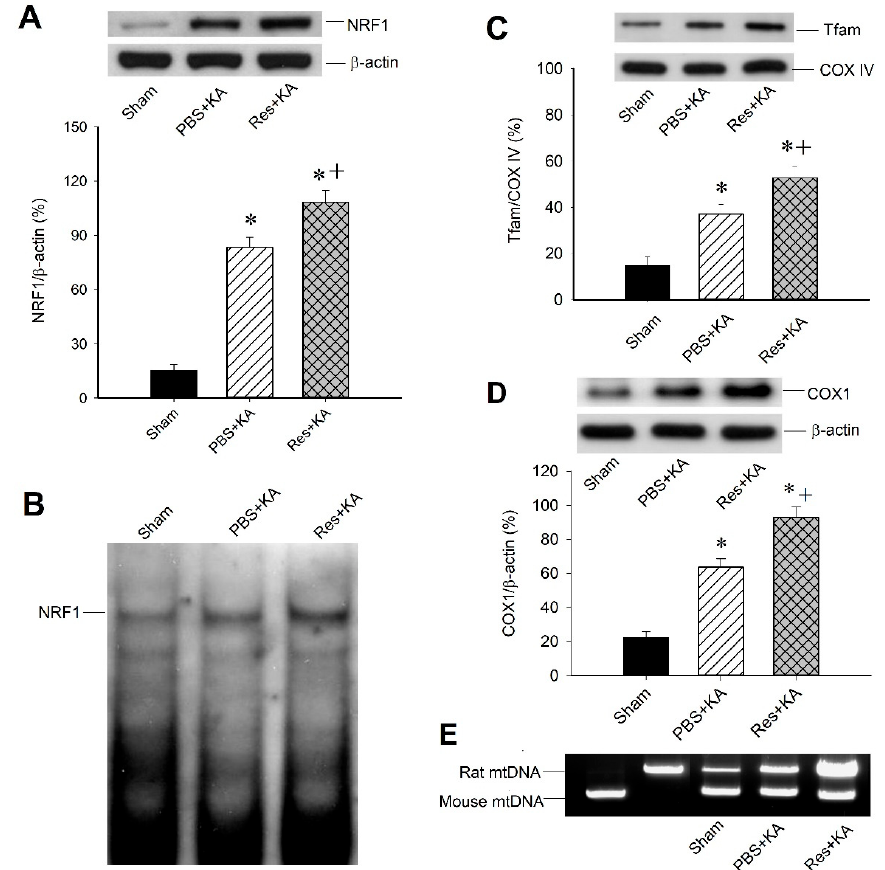
Figure 4. Effects of resveratrol on mitochondrial biogenesis in kainic acid (KA)-induced status epilepticus in hippocampal CA3 subfield. ( A ) Pretreated microinjection with resveratrol (Res, 100 µ mol) into the hippocampus increased KA-induced NRF1 expression. ( B ) In accordance with NRF1 protein expression, DNA binding activity of NRF1 measured by electrophoretic mobility shift assay also increased with microinjection with resveratrol (100 µ mol) into the hippocampus. ( C ) Pretreated microinjection with resveratrol (100 µ mol) into the hippocampus enhanced Tfam expression 24 h after KA treatment. ( D ) Mitochondrial protein, COX1, and ( E ) mtDNA content increased in rats with pretreated microinjection with resveratrol (100 µ mol) into the hippocampus. Values are mean ± SEM of quadruplicate analyses from six animals per experimental group. * p < 0.05 versus sham control group, + p < 0.05 versus PBS + KA group in the Scheffé multiple-range test.